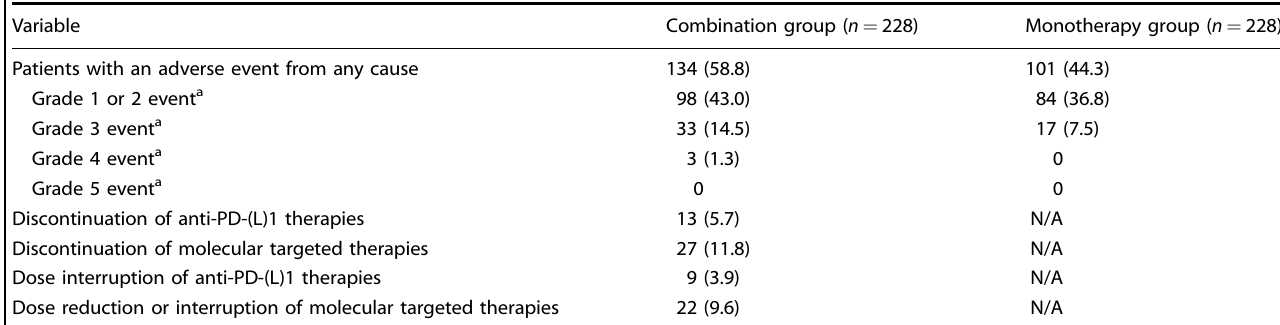
Table 3. Adverse events from any cause after